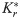
Distribution of the May 2017 English Wikipedia articles devoted to cancers and drug cancers in the local CheiRank Kr*—PageRank Kr plane.The Ncr = 37 (Nd = 203) articles devoted to cancers (drug cancers) are represented by green (gold) plain circles.